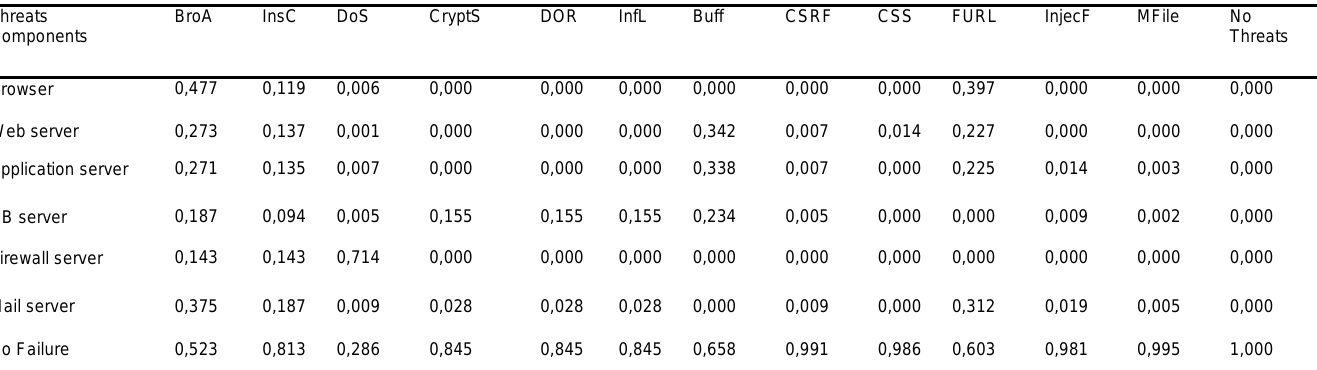
Table 5: The initial Impact Matrix (IM)